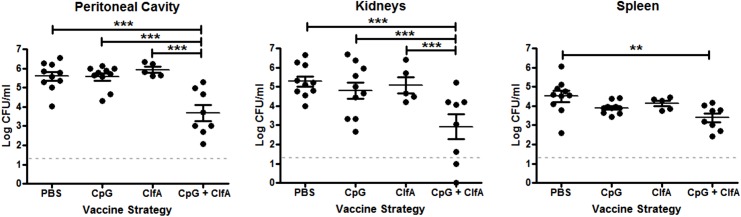
Vaccine-induced type 1 immunity protects against S. aureus infection.Mice were vaccinated with CpG (50μg/mouse), ClfA (1μg/mouse), or CpG+ClfA via s.c. injection on d 0, 14 and 28. On d 63 mice were challenged with S. aureus (5x108 CFU) via i.p. injection alongside a control group of sham-immunised (with PBS) mice. At 72 h post-infection, bacterial burden was assessed in the peritoneal cavity, kidneys and spleen. Results expressed as log10 CFU/ml with means indicated by bars. n = 5–10 per group. **p<0.005, ***p<0.001.